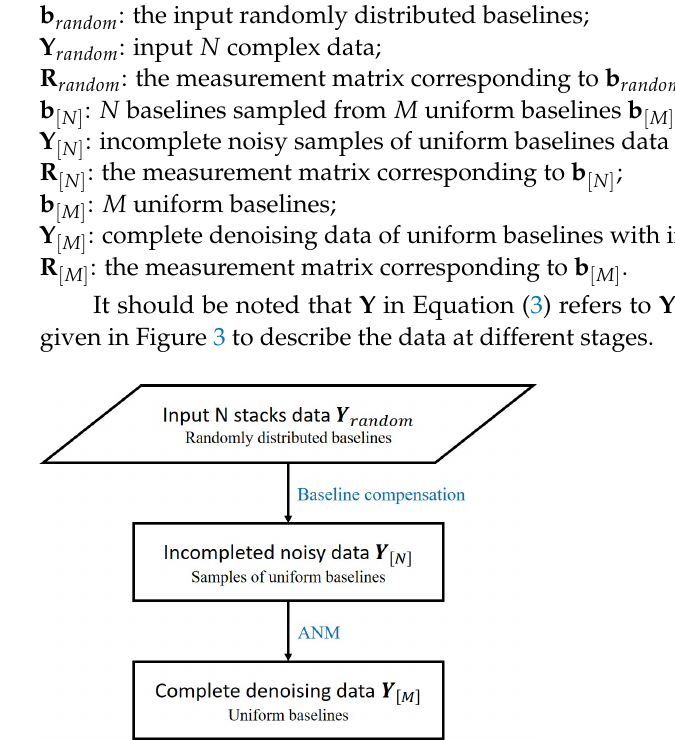
Figure 3. Data description at different